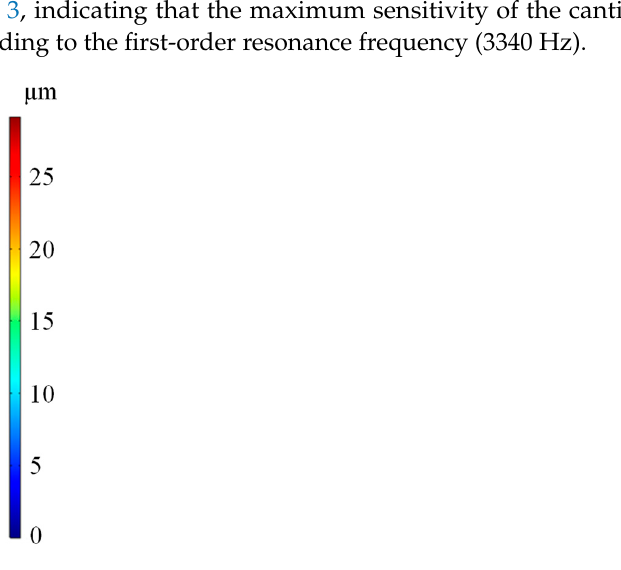
Figure 2. The vibration pattern of the cantilever at the first-order resonance frequency (external sound pressure = 1 Pa).